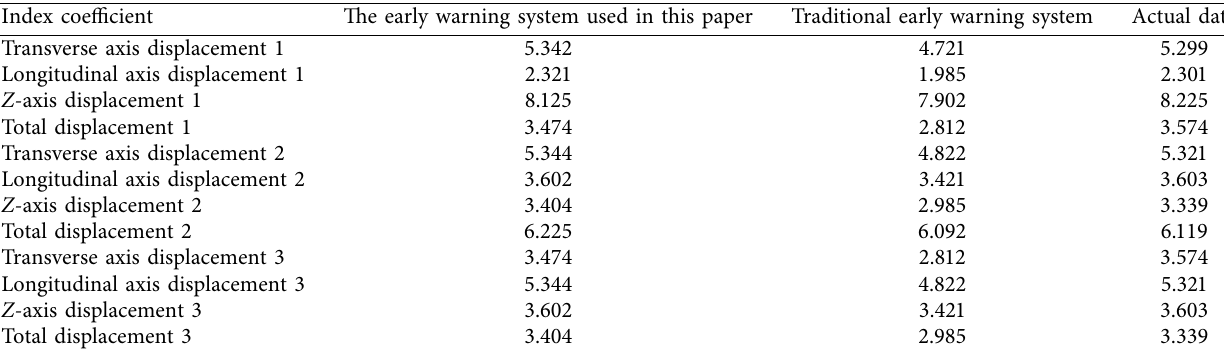
Table 4: Comparison of experimental data in area 3.